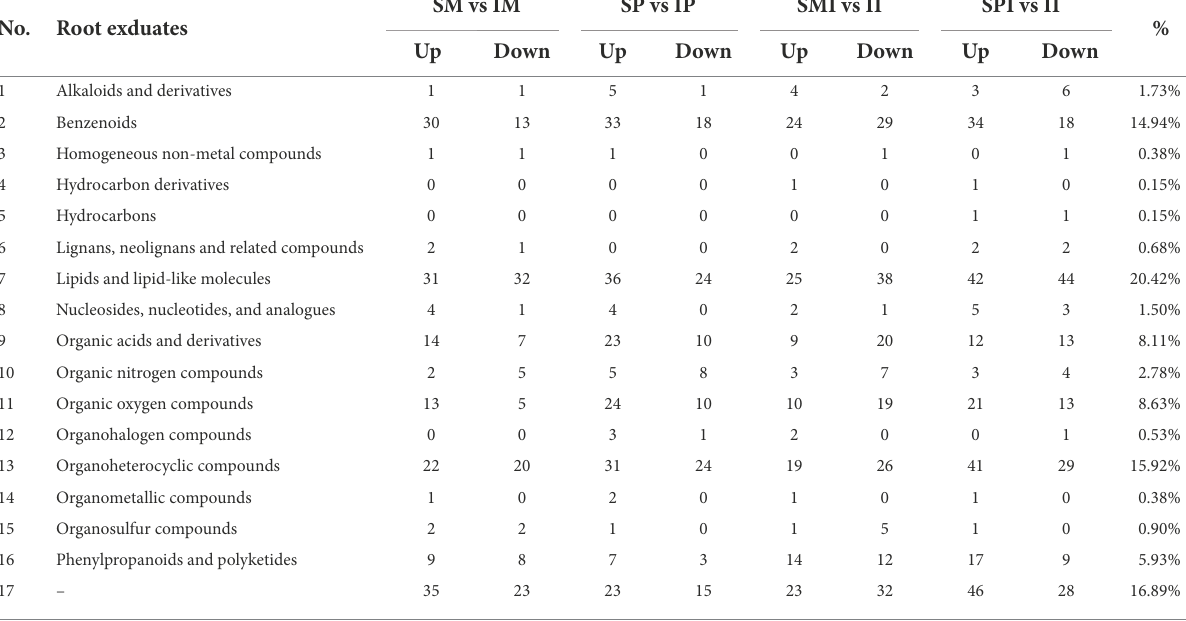
TABLE 2 The categories of maize and peanut root exudates in rhizosphere soil under different planting patterns.